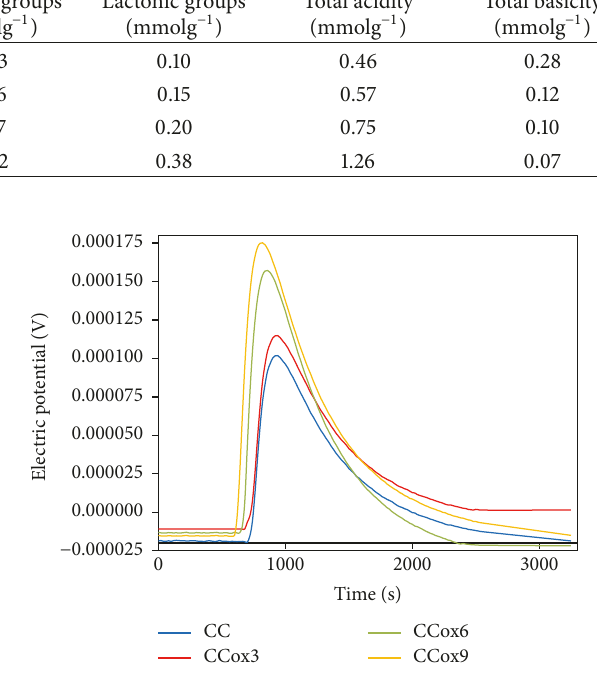
Figure 2: Immersion calorimetric curves of the carbonaceous solids in an aqueous ion Ni(II) solution of 100 mgL −1